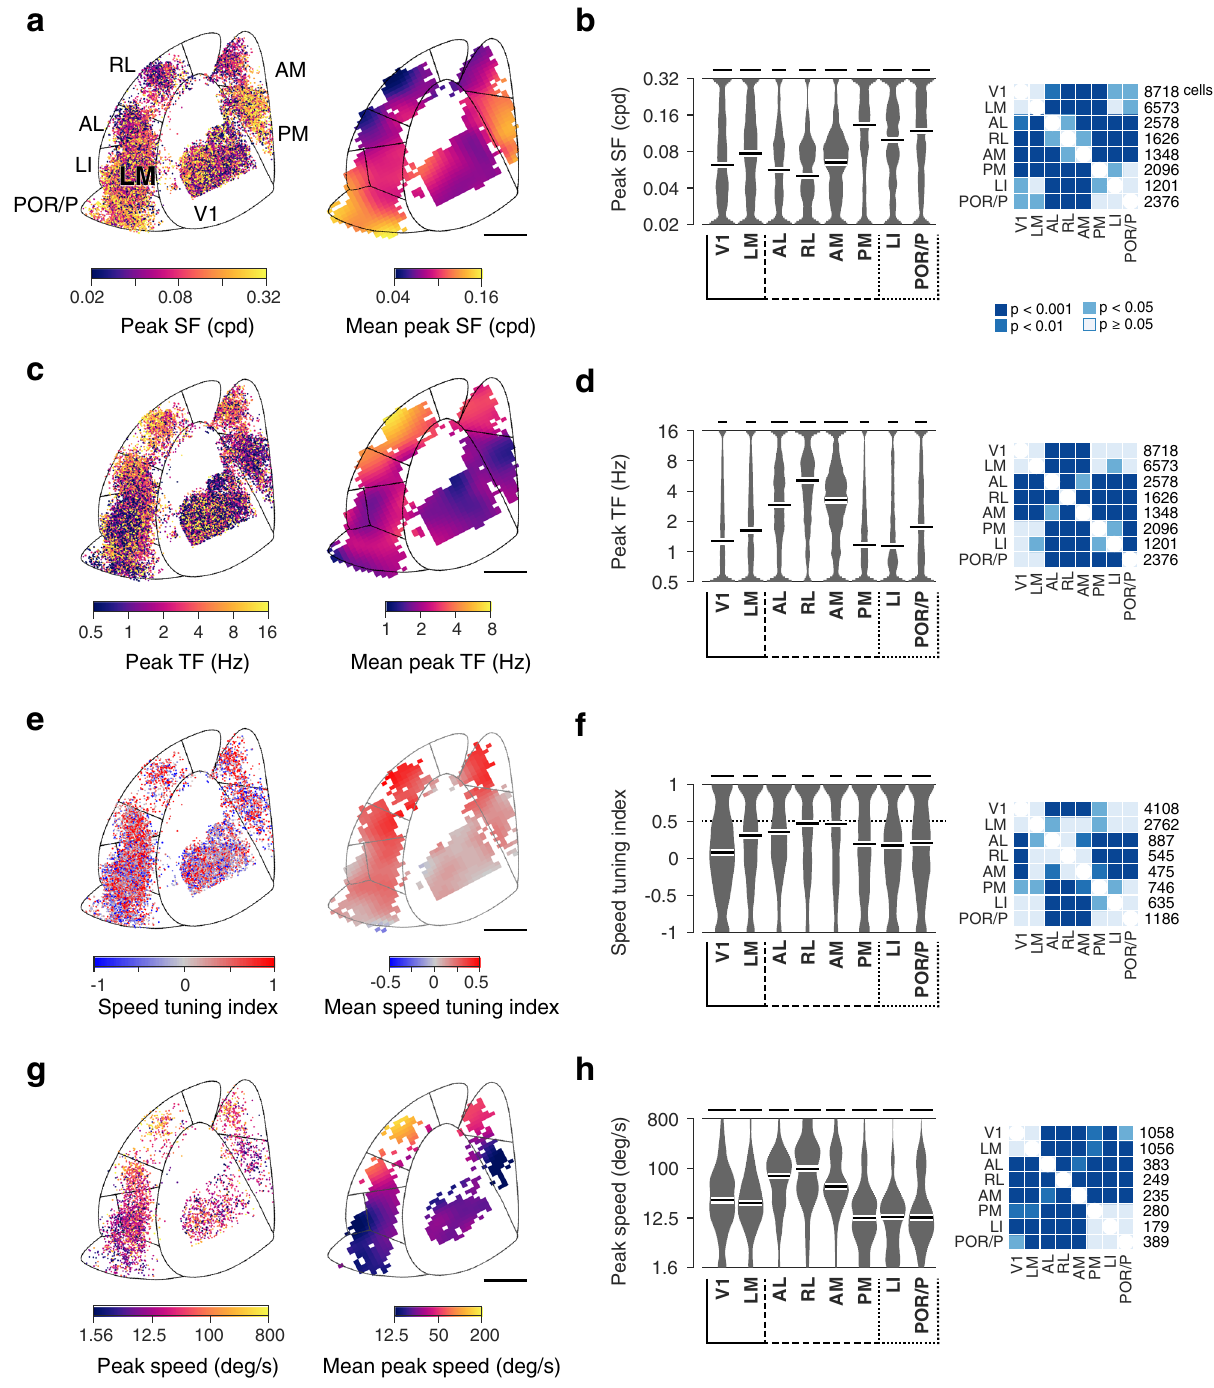
Fig. 3 Comparison of spatial and temporal frequency preferences, speed selectivity and preference in V1, LM and dorsal and ventral visual areas. a Distributions of observed spatial frequency preferences across visual cortical areas. Left: color-coded map of peak spatial frequency for individual neurons as function of cortical location. Right: spatially-smoothed map (Gaussian fi lter width 400 µ m). Data across animals (n = 10) presented within the common delineation. Scale bar: 1mm. b Left: Probability density functions of observed peak spatial frequency preferences for each visual area. Kernel density estimator bandwidth 0.05; scale bar: 2% cells; white bars: median value. Right: two-sided hierarchical bootstrap KS tests assessing statistical signi fi cance of differences in density functions across visual areas accounting for inter-animal variability; see details in Methods. c , d Distributions of peak temporal frequency preferences across areas, same format as a and b . e and f Distributions of speed tuning index (SI) across areas, same format as a and b . The dashed line indicates the selection threshold for speed-tuned cells (SI > 0.5, dataset 1). g , h Distributions of peak speed of speed-tuned cells, same format as a and b . SF: spatial frequency. TF: temporal frequency. Scale bars in d , f , h represent 1.5, 1, 0.5% cells, respectively.